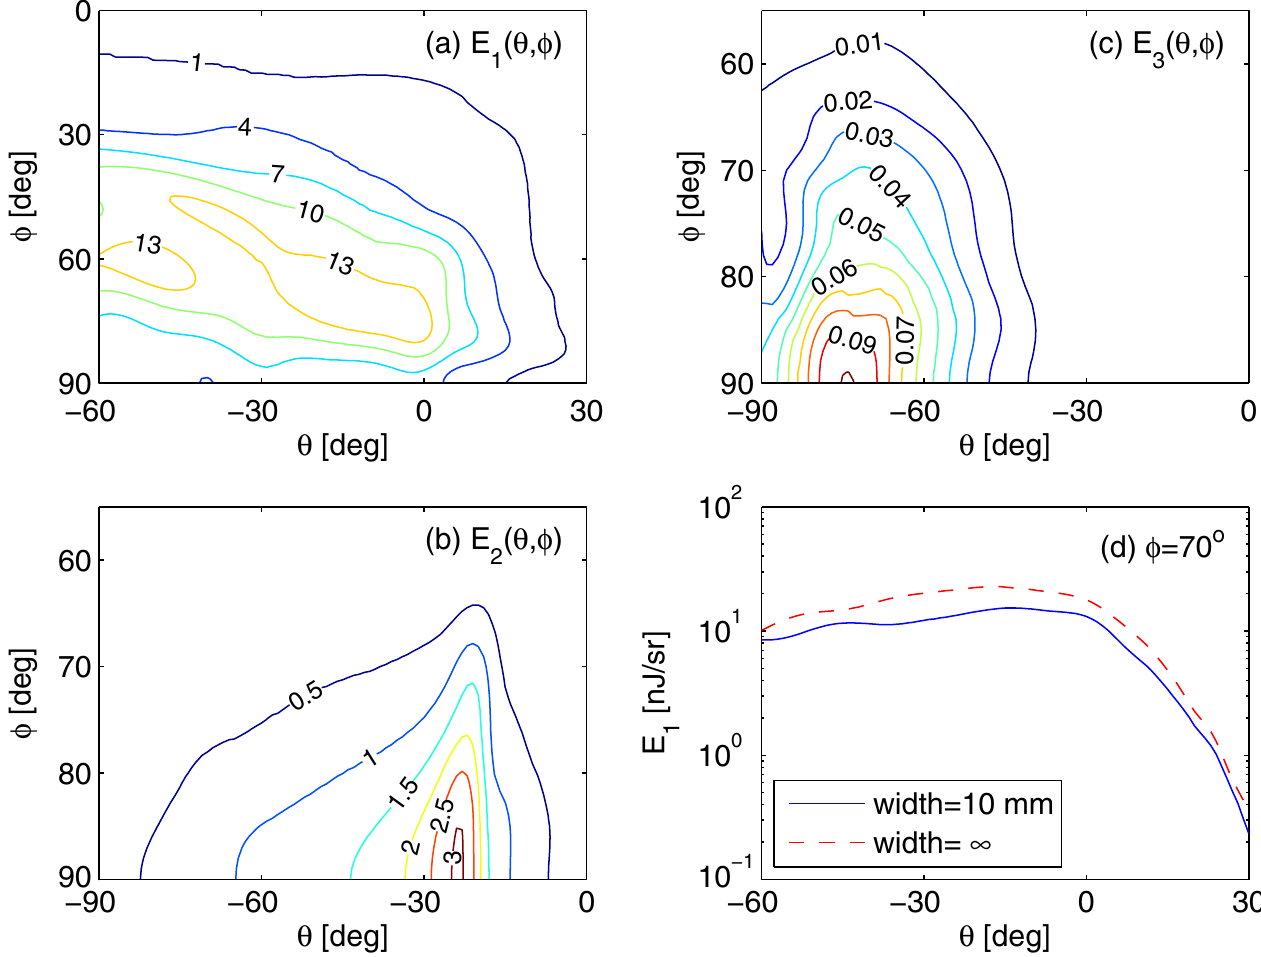
FIG. 6. (Color) Contour plot of the radiated energy in nJ = sr vs observation angles (cid:3) and (cid:4) for the first (a), second (b), and third (c) Smith-Purcell orders calculated by Eq. (15). (d) First order radiated energy for (cid:4) ¼ 70 (cid:7) by the 10-mm wide grating (solid line) compared to the radiated energy by an infinitely wide grating [30] (dashed